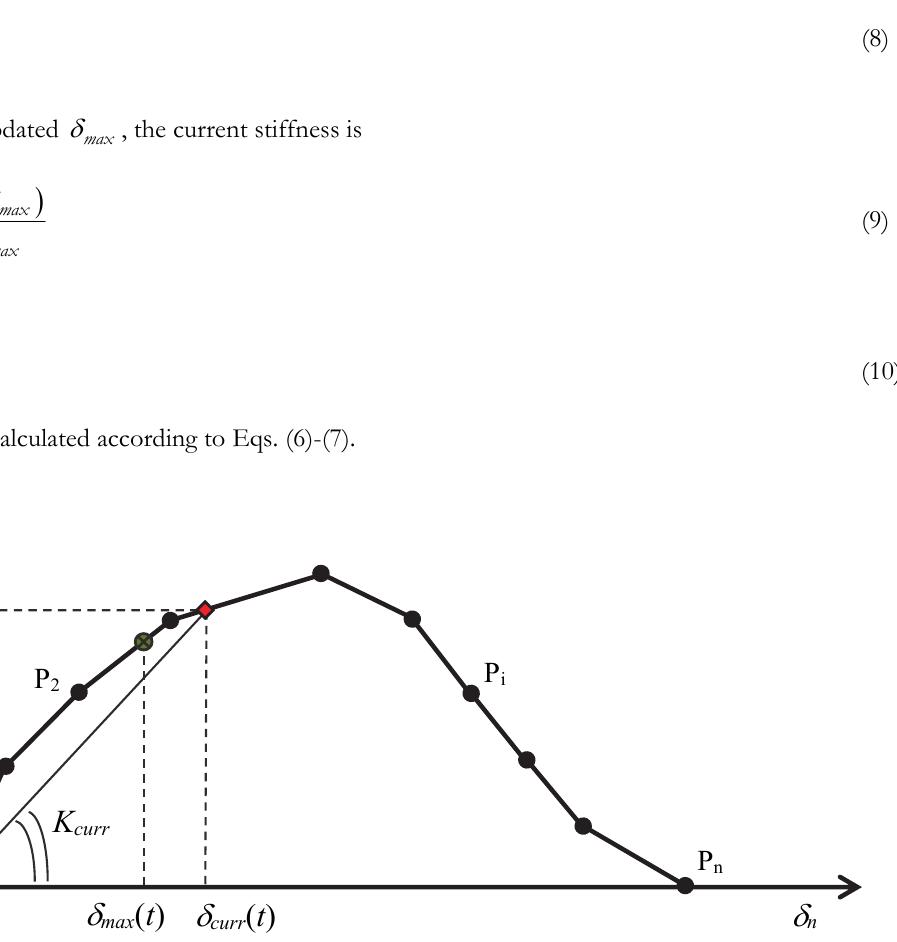
Figure 4: Interpolated cohesive law – opening of the